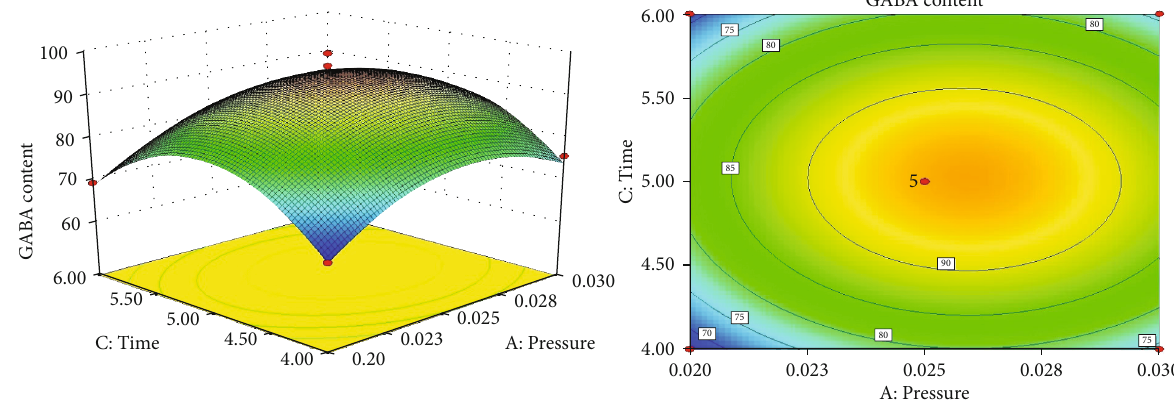
Figure 7: Response surface and contour diagram of pressure and time in fl uence on GABA content.